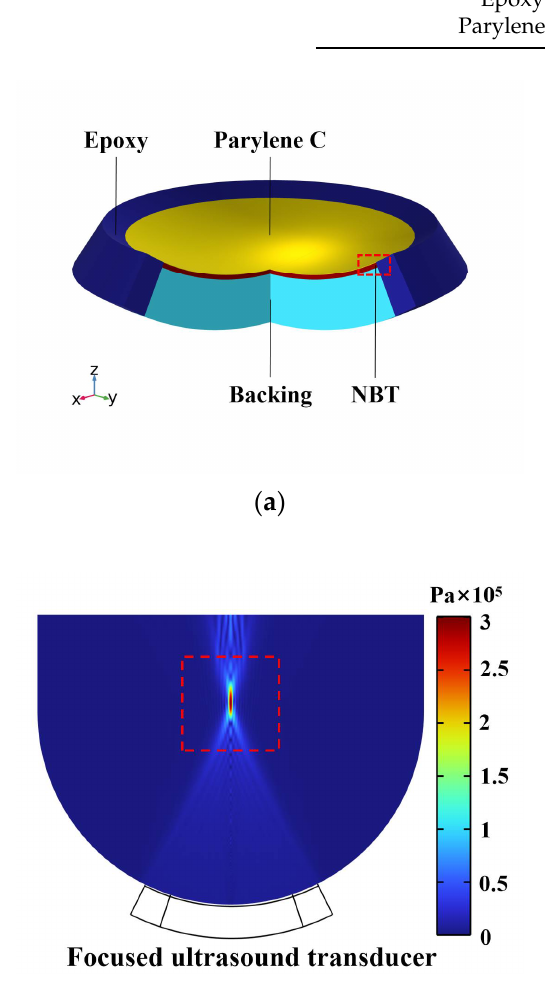
Figure 3. Modeling results of NBT-Nb-Mn single element transducer from KLM model-based sim-